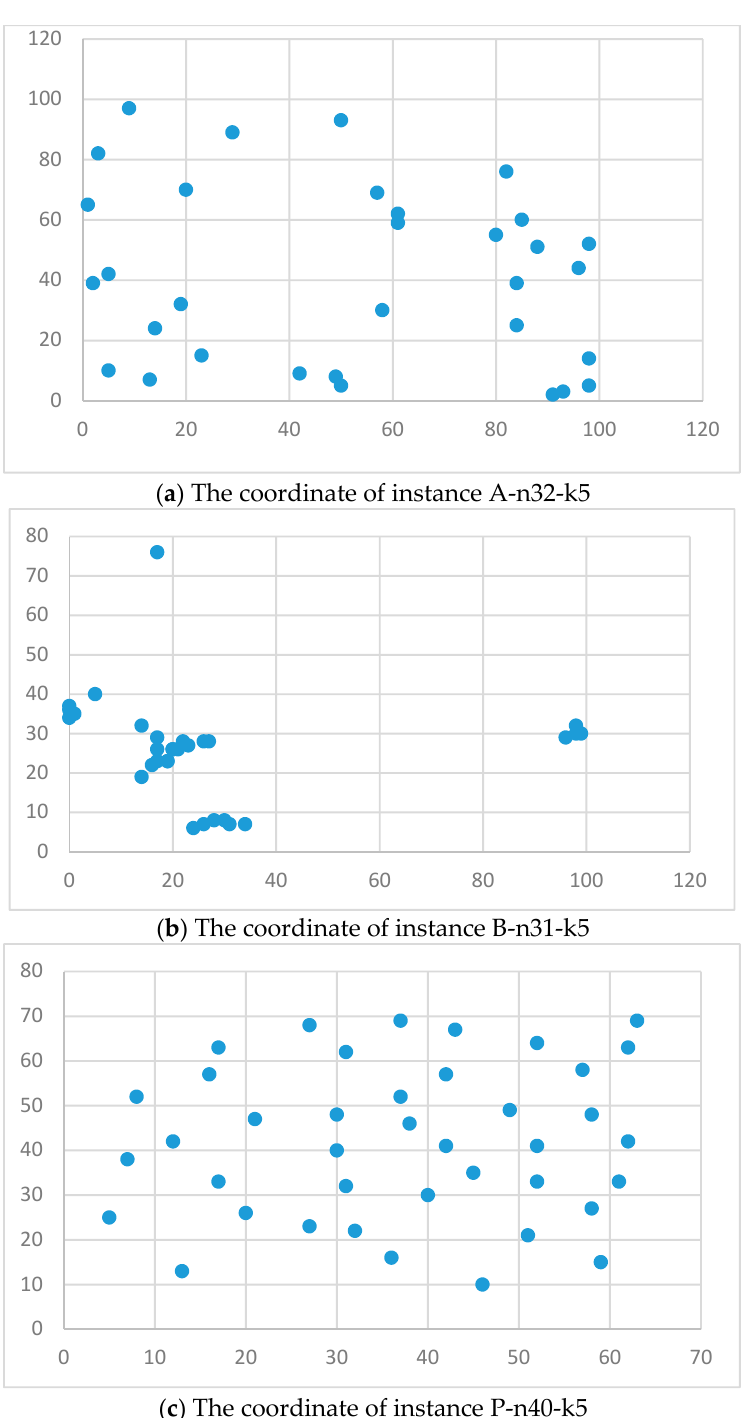
Figure 4. Examples of the coordinates of instances in Groups A, B, and P.